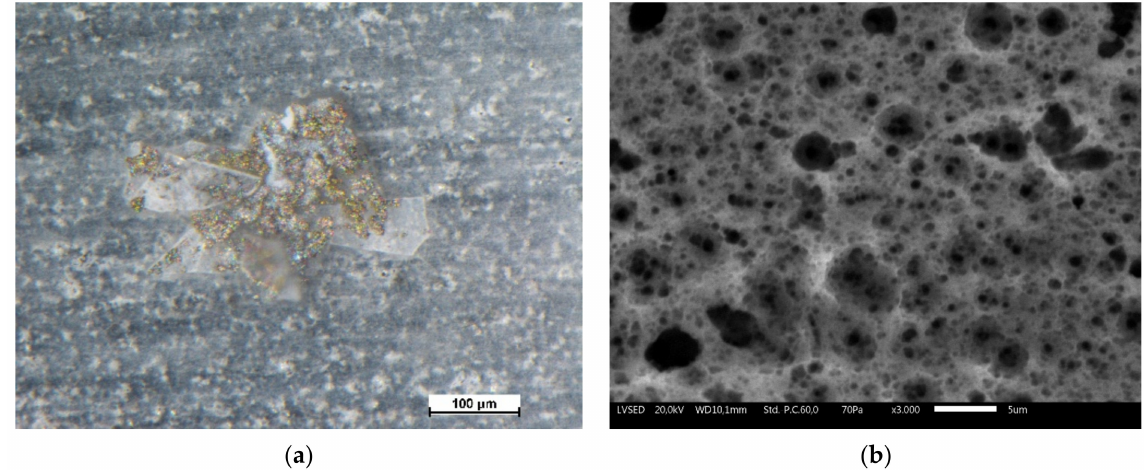
Figure 6. Corrosion product of sample X observed at the stereomicroscope ( a ) and degradation of the relative alumina layer analysed by SEM ( b ), after 24 h of test.